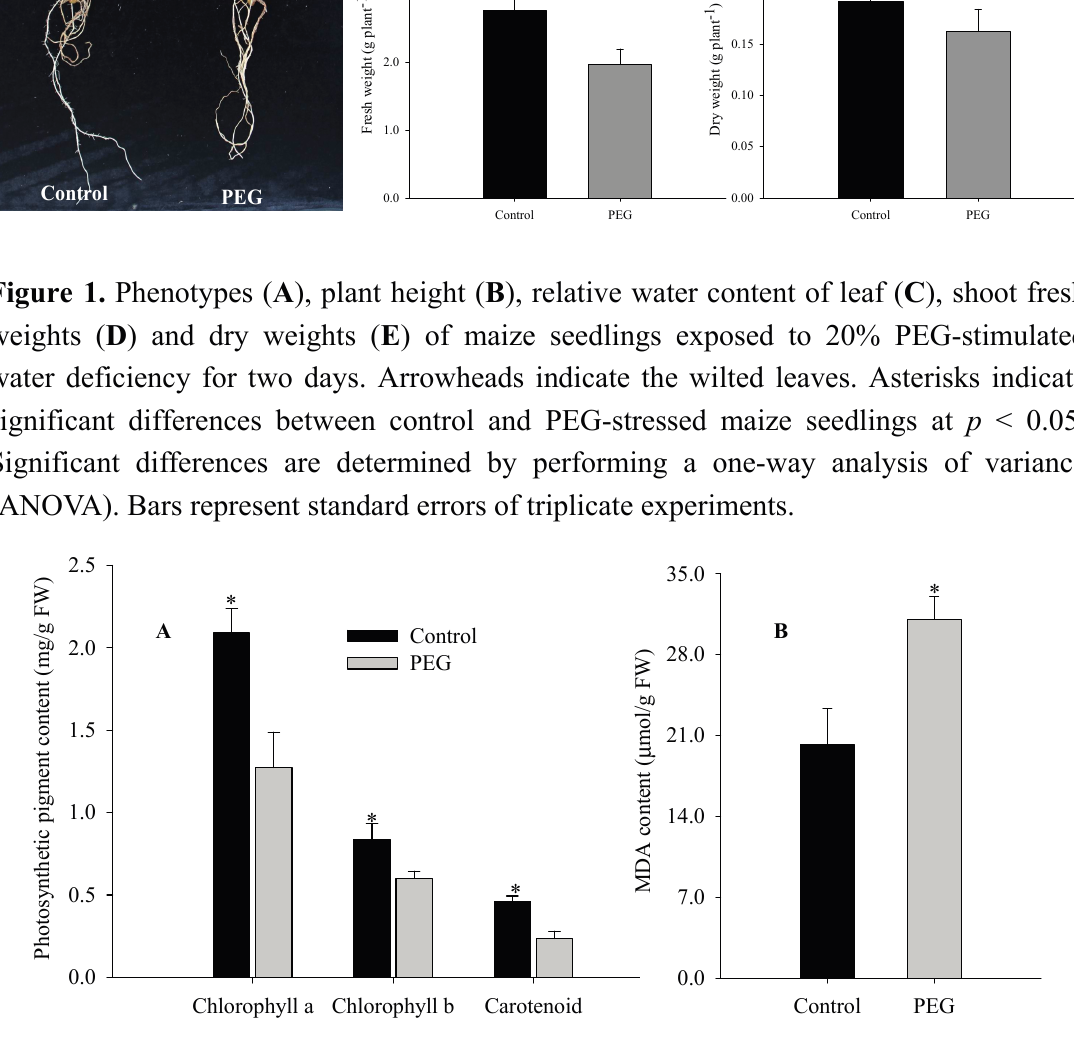
Figure 2. Contents of pigments ( A ) and MDA ( B ) in leaves of maize seedlings exposed to 20% PEG-stimulated water deficiency for two days. Asterisks indicate significant differences between control and PEG-stressed maize seedlings at p < 0.05. Significant differences are determined by performing a one-way analysis of variance (ANOVA). Bars represent standard errors of triplicate